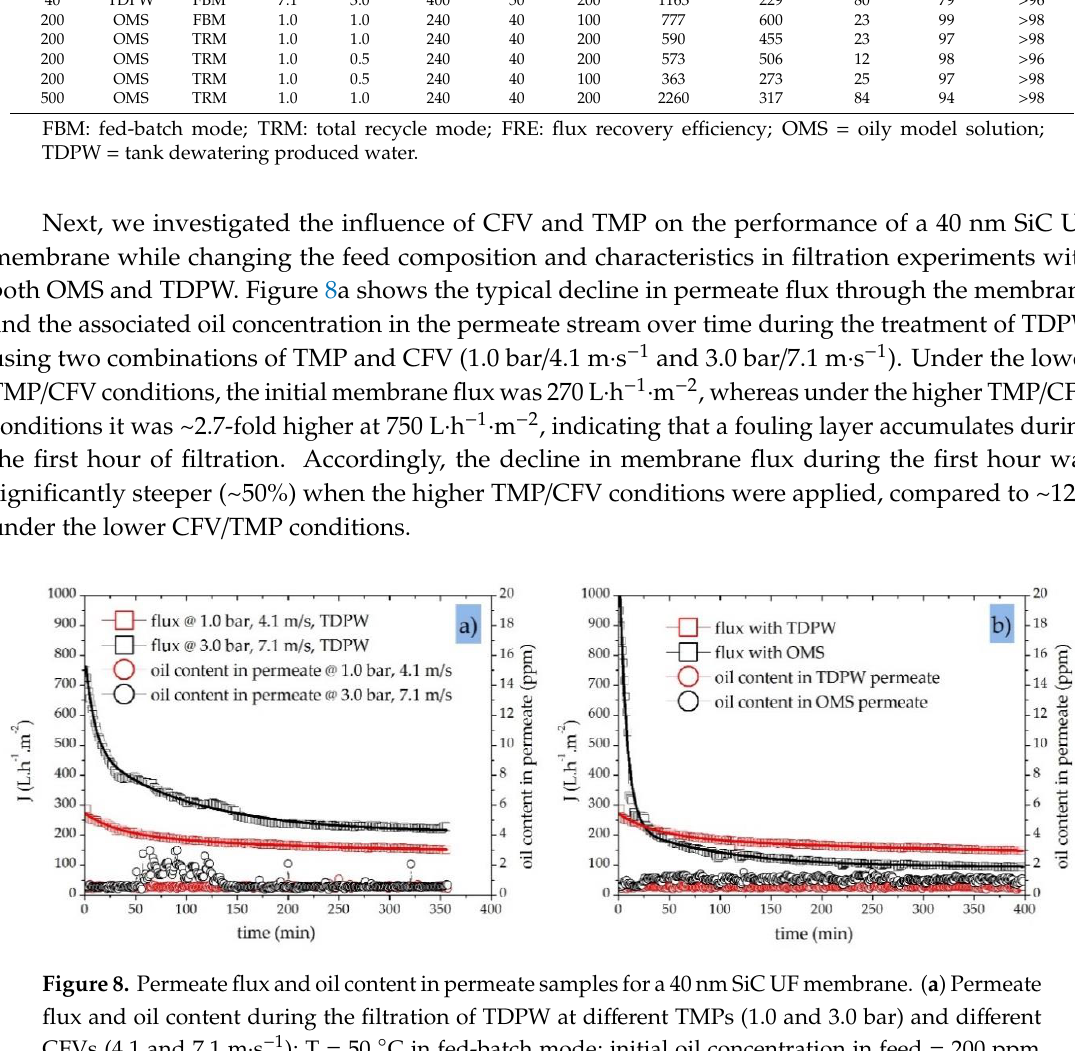
Table 5. Selected flux and oil retention data for SiC MF and UF membranes.